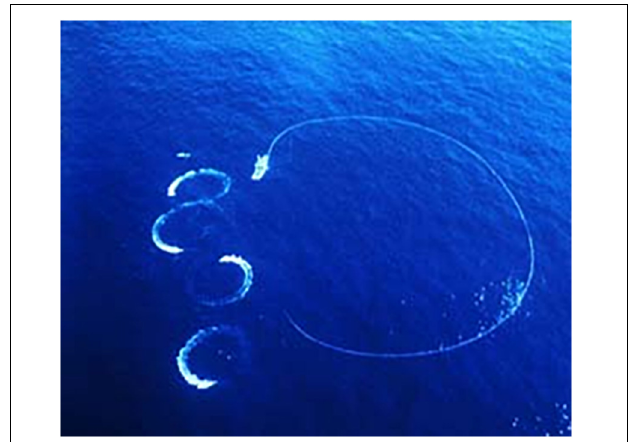
FIGURE 1 | Aerial photograph of a purse-seine set on a school of tuna and dolphins. The purse-seine vessel is deploying the net in a large circle around the entire school while a skiff holds the end of the net in place. In this photograph the net is not yet closed; four speedboats are driving in tight circles near the opening to prevent the dolphins (and tuna) from escaping. Source: Inter-American Tropical Tuna Commission.